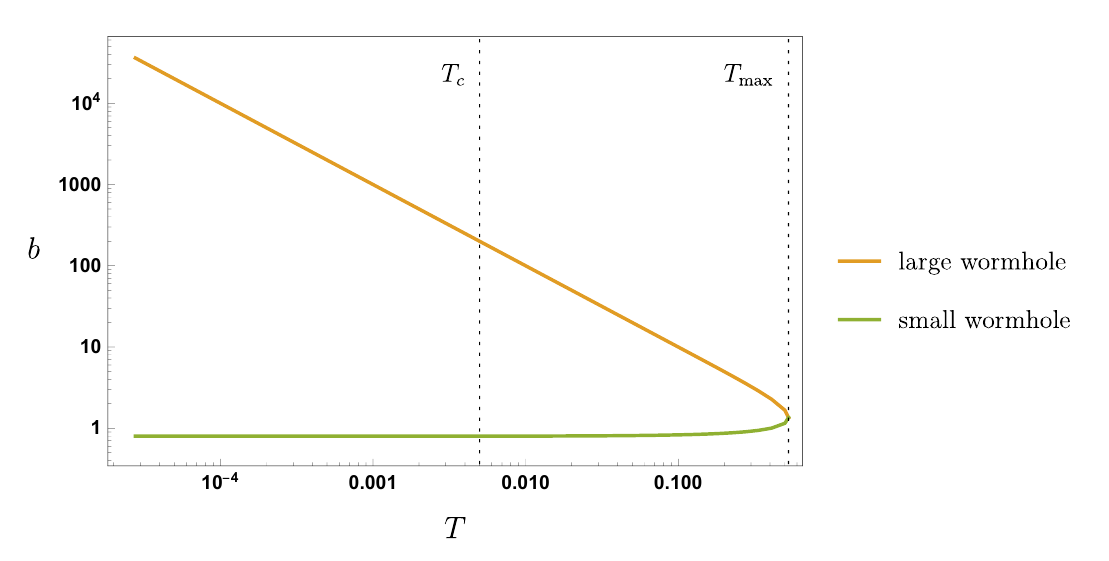
Figure 7 . Log-log plot of the size b of the wormhole as a function of the temperature. The plot is done using Λ 0 = 1 and S 0 = 10 2